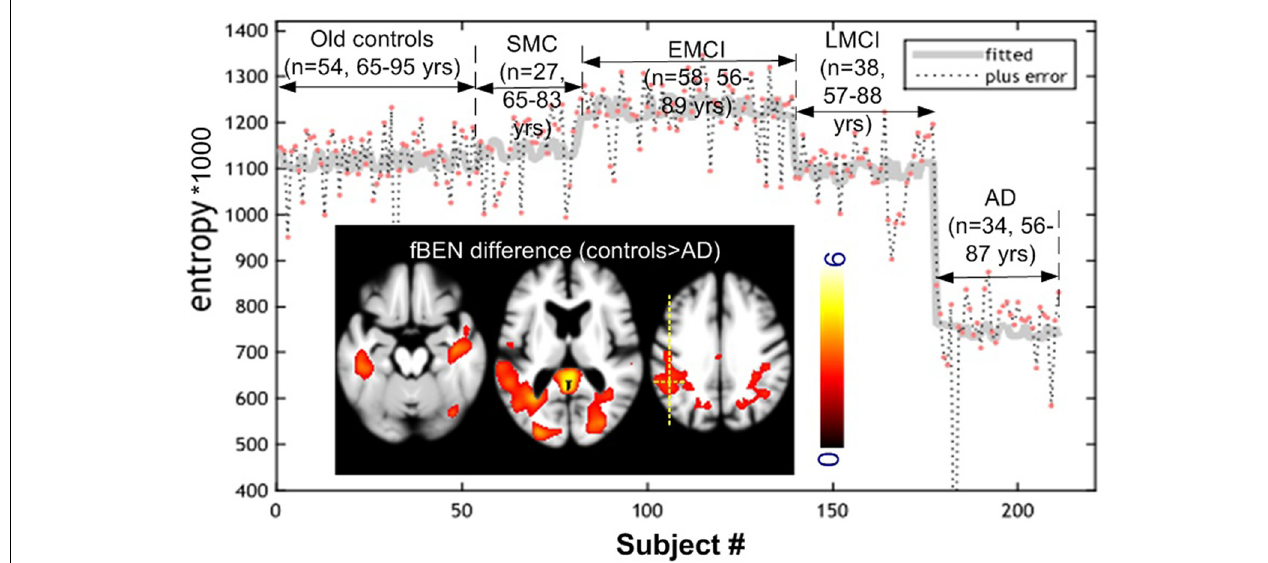
FIGURE 2 | Cross-sectional brain entropy (BEN) profile identified from ADNI rsfMRI. BEN slightly increased from old controls to significant memory concern (SMC) and then early mild cognitive impairment (EMCI), but reduced from EMCI to late mild cognitive impairment (LMCI), and then AD at an accelerated pace. The inset figure shows the post hoc control > AD (red spots in the three image slices) BEN difference ( P < 0.005, cluster size > 300 corrected). The gray curve was the fitted line of BEN from different populations from the same position marked by the yellow cross. Color bar indicates the display window for the t-map shown in the three image